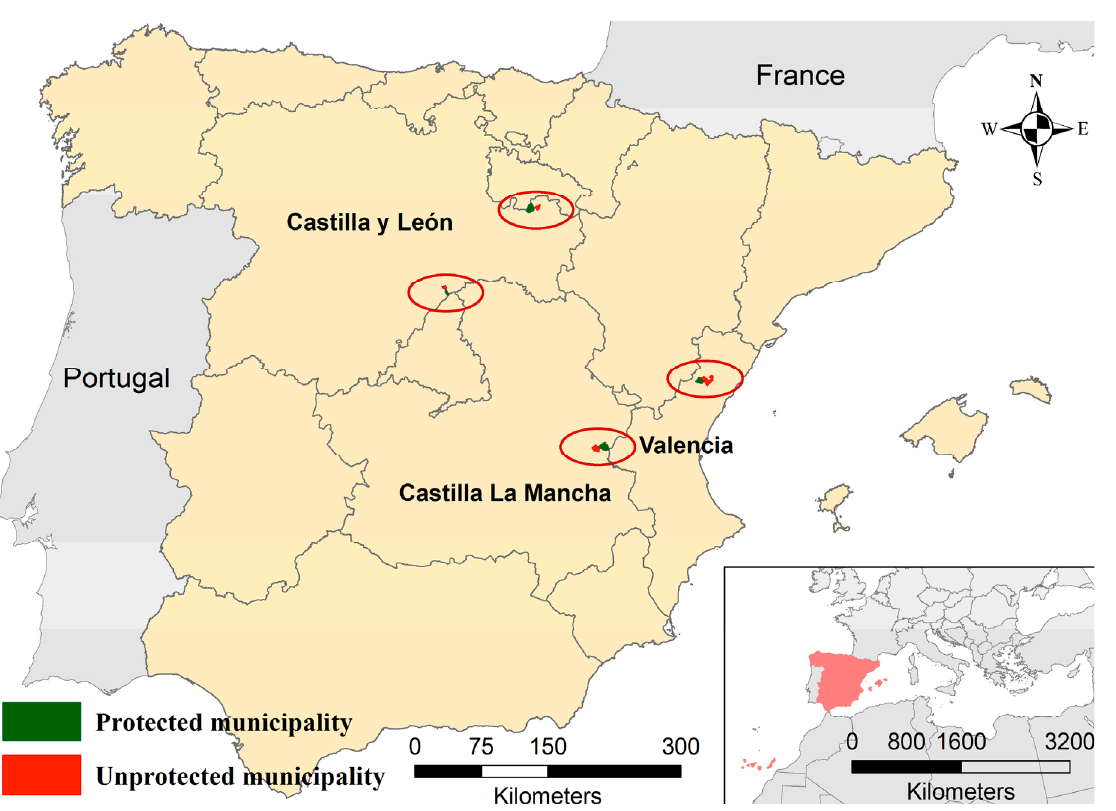
Figure 1. Location of the four pairs of municipalities in